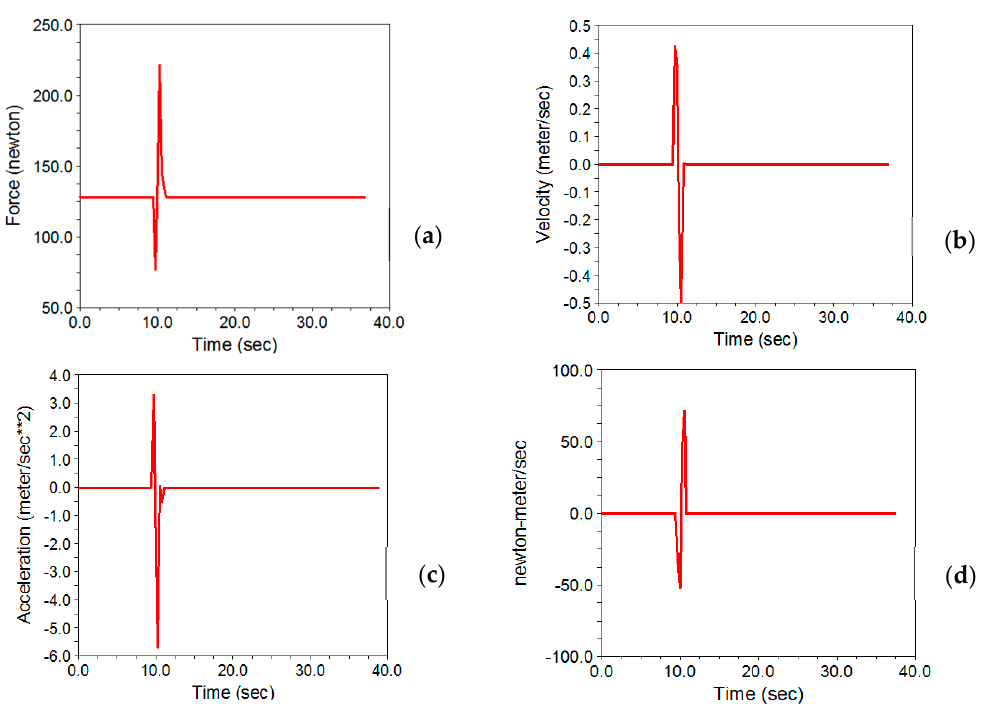
Figure 21. Results of ADAMS software simulation to determine the motor characteristics of the gutting subset (seven fish per minute). In this figure, ( a – d ) are force, velocity, acceleration, and required power respectively.